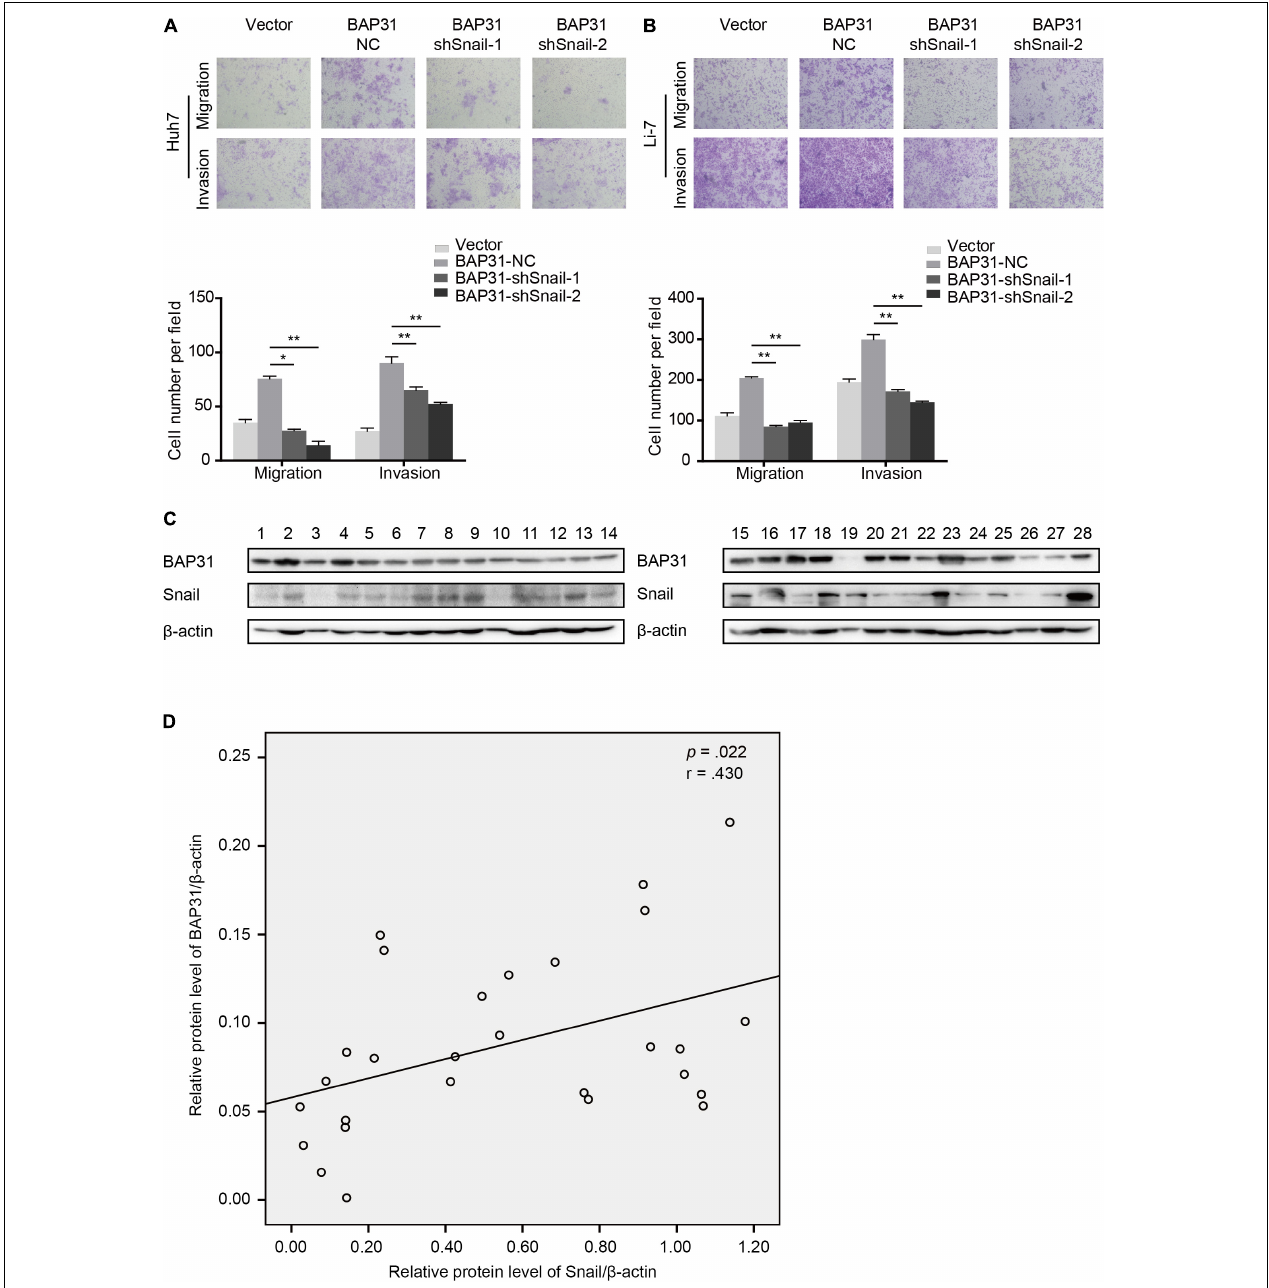
FIGURE 6 | BAP31 promoted HCC cell migration and invasion via Snail and there was positive correlation between BAP31 and Snail in HCC. (A–B) Transwell assay analysis of the migratory and invasive abilities of Huh7 and Li-7 cells, which were divided into four groups: vector, BAP31-NC, BAP31-shSnail-1 and BAP31-shSnail-2. Representative images (upper) and the statistical analysis (lower) were shown. Results were presented as mean ± SD and t -test was conducted between BAP31-NC and BAP31-shSnail-1/-2 group ( n = 3, * p < 0.05, ** p < 0.01). (C–D) Western blot analysis showed the positive correlation between protein expression of BAP31 and Snail in HCC tissues ( n = 28, p = 0.022, r =